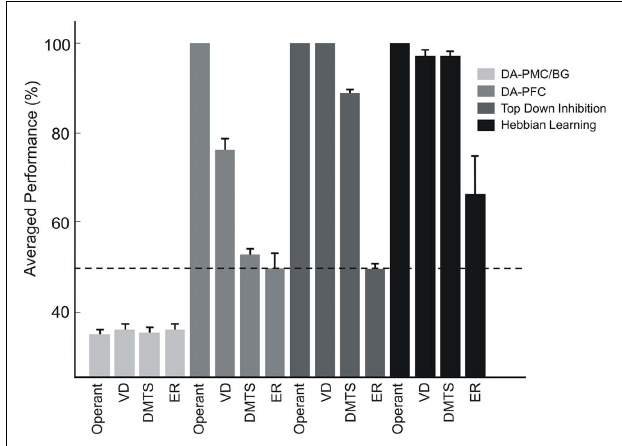
FIGURE 8 | Effects of lesions. Four types of lesions were conducted over the necessary mechanisms for ER learning. Lesions to the dopaminergic afferents to the output layer (DA–PMC/BG) impair the ability to build stimuli responses mappings, and models perform at chance, that is, all responses have the same probability of being executed. On the other hand, lesions to the PFC dopamine afferents only impair the acquisition of DMTS and ER, both tasks containing non-linear separable input patterns. Disruption of Hebbian learning at the input structures and top-down inhibition mechanisms does not affect the learning of simple operant tasks neither DMTS. In contrast, ER cannot be learned if any of the mechanisms here lesioned are not working properly. Dashed line indicates chance